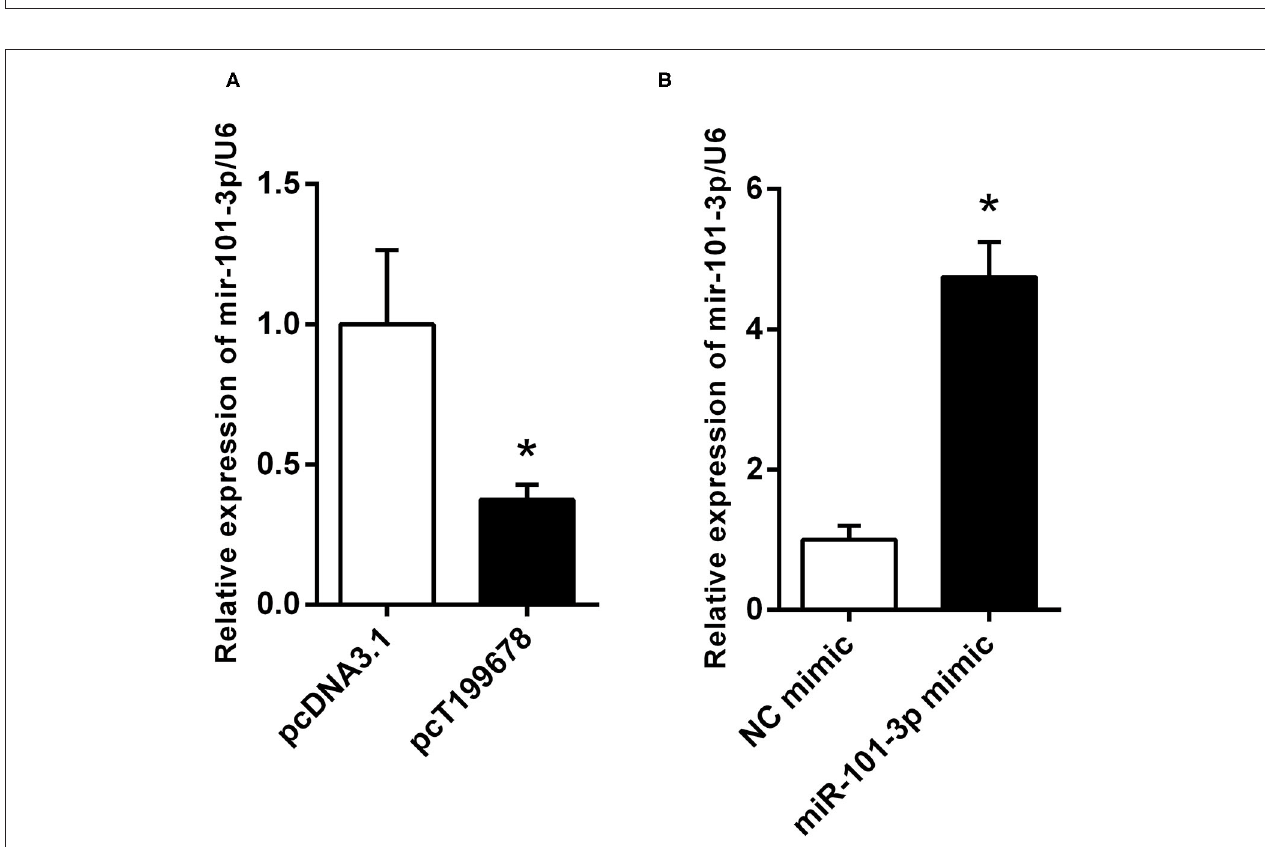
FIGURE 5 | lncRNA-T199678 regulated the expression of miR-101-3p. (A) Overexpressed lncRNA-T199678 significantly downregulated the expression of miR-101-3p via qPCR (* P < 0.05). (B) Construction of overexpressed miR-101-3p in the SH-SY5Y cell line (* P <